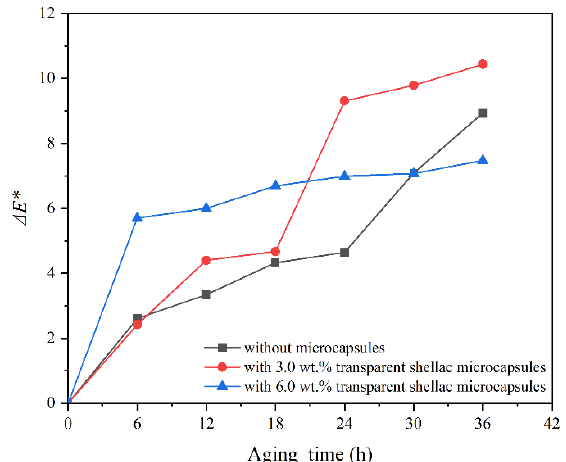
Figure 9. The ∆ E* of the coating on Beli wood with transparent shellac microcapsules after aging.